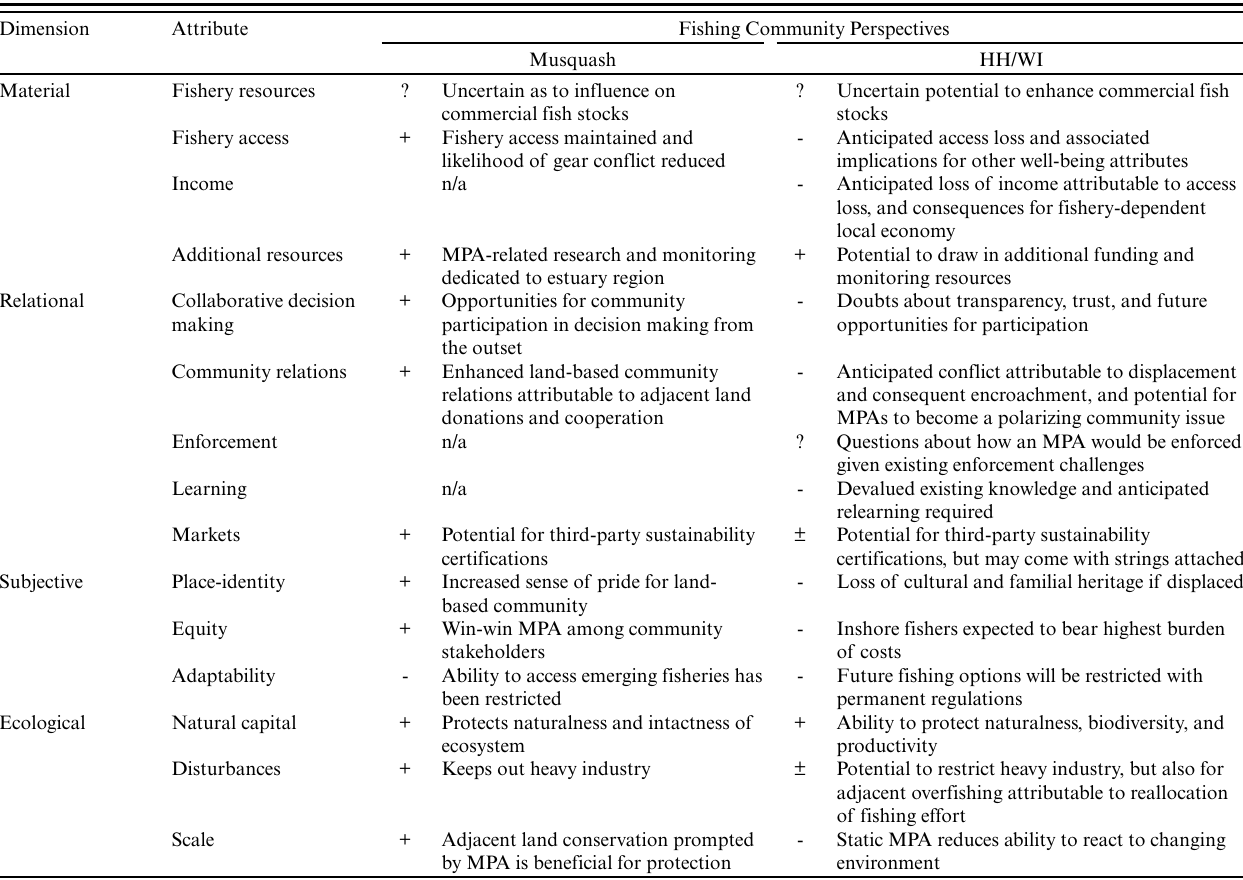
Table 4 . Perceptions of benefits and costs of marine protected areas (MPAs) across social-ecological well-being attributes and cases: benefit (+), cost (-), mixed (±), uncertain (?), not identified (n/a). HH/WI, Head Harbour, West Isles Archipelago, and The Passages.